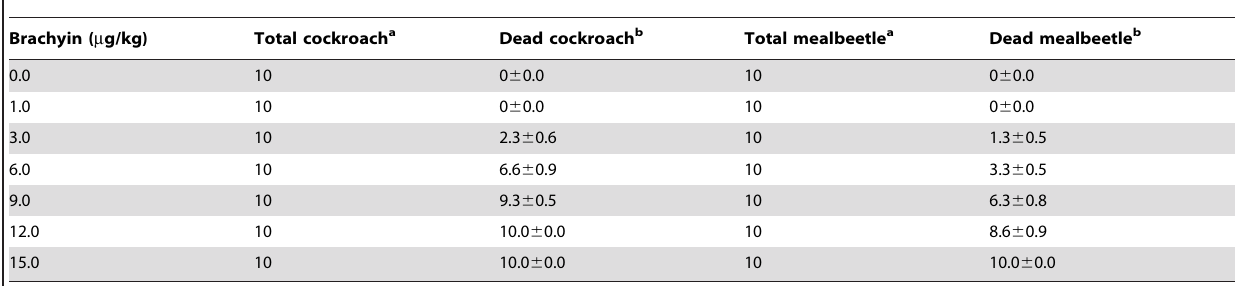
Table 1. The insecticidal activity of brachyin.